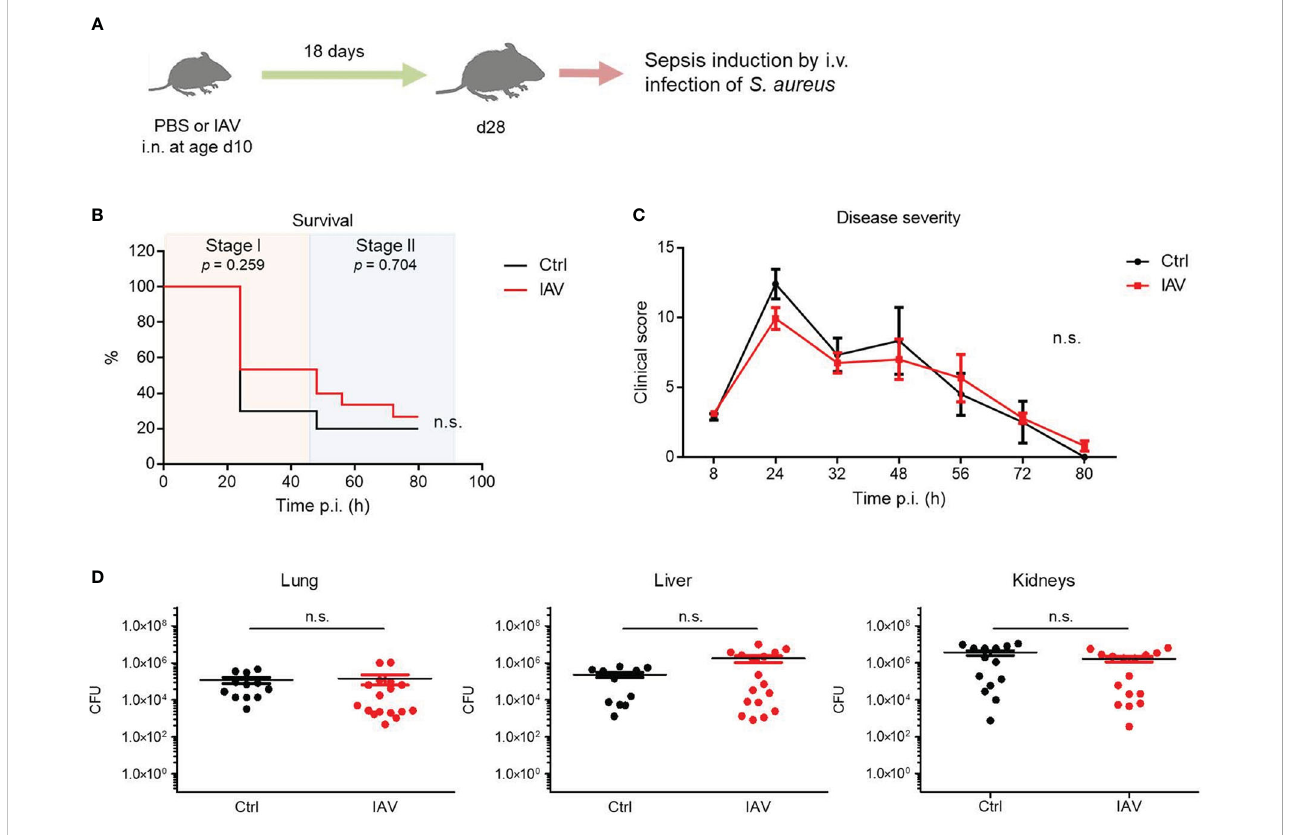
FIGURE 2 Exposure to IAV beyond the neonatal period has no impact on the later defense of S. aureus . Mice were treated i.n. at d10 of life with PBS (control, Ctrl) or 5 PFU of IAV. After 18 days, sepsis was induced in these mice by i.v. application of S. aureus . (A) Experimental setup. (B) Survival was observed for 80 h p.i. and plotted as percentages over time (Mantel-Cox test). (C) Clinical scores assigned at indicated time points p.i., plotted as means ± SEM ( post hoc 2-way ANOVA Bonferroni test) (Ctrl n = 10, IAV n = 15, each from 2 litters). (D) Bacterial burden was determined in independent experiments in indicated organs 80 h p.i. (each group n = 12-17 from 7 litters, respectively). Plotted are means ± SEM. n.s., not signi fi cant (MWU